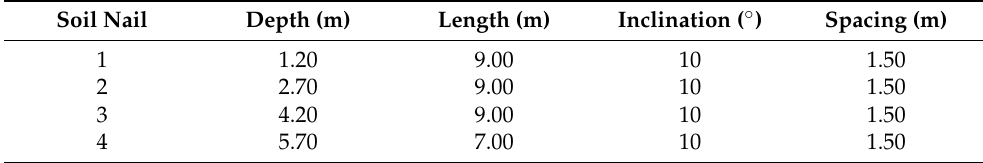
Table 1. The mechanical parameters of the soil